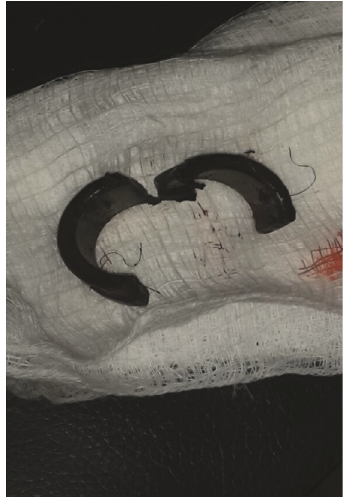
Figure 2: Thick constricting penile ring cut in 2 places.